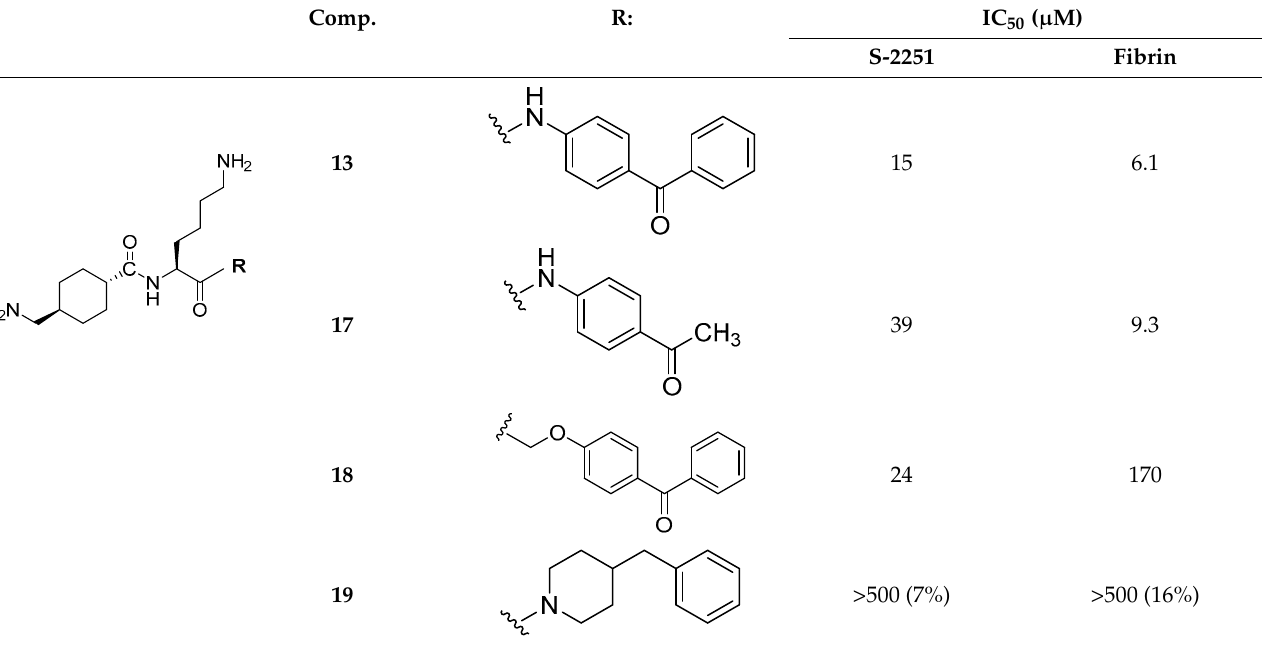
Table 5. Plm inhibitory activity of compounds 17–19 [29]. Comp.